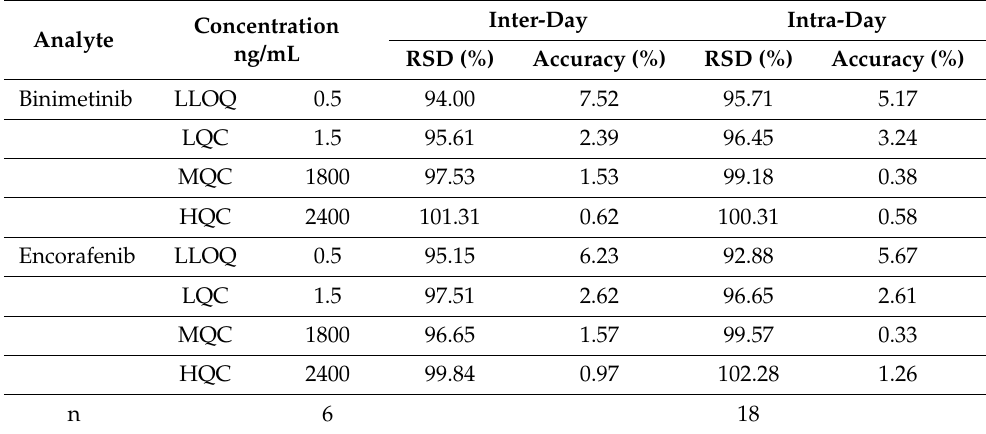
Table 3. The accuracy and precision data for the determination of binimetinib and encorafenib in rat plasma.